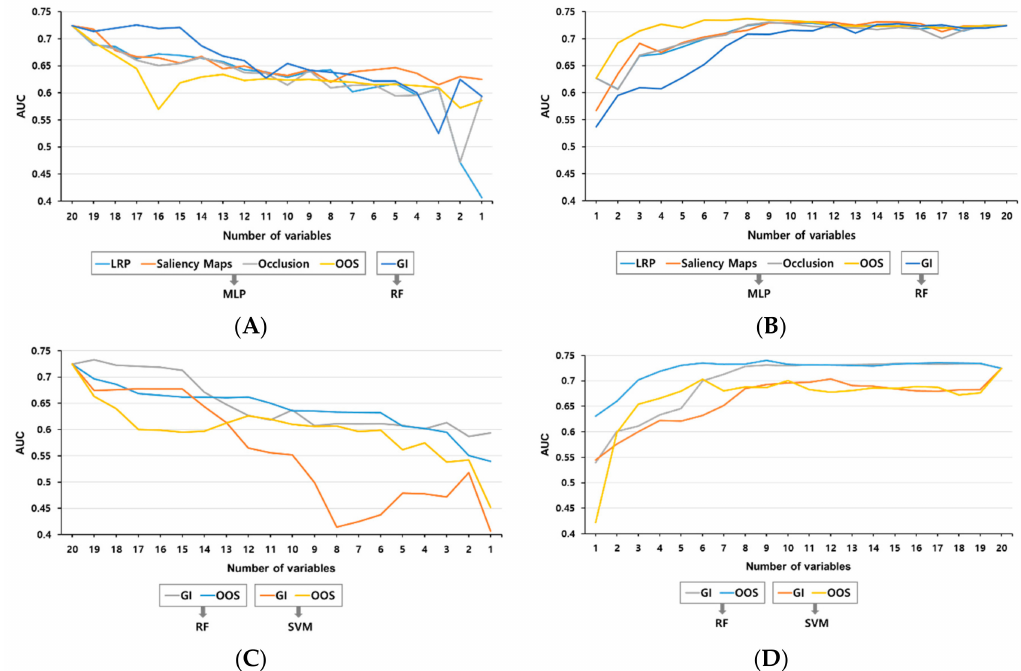
Figure 3. Changing trend of the area under the receiver operating characteristic curve for variables added or removed by ranking. ( A ) Analysis with removed variables according to ranking. ( B ) Analysis with added variables according to ranking. ( C ) Non-ANN analysis with removed variables according to ranking. ( D ) Non-ANN analysis with added variables according to ranking. GI, Gini importance; LRP, Layer-wise Relevance Propagation; OOS, one-out search. ANN, artificial neural network; MLP, multi-layer perceptron; RF, random forest; and SVM, support vector